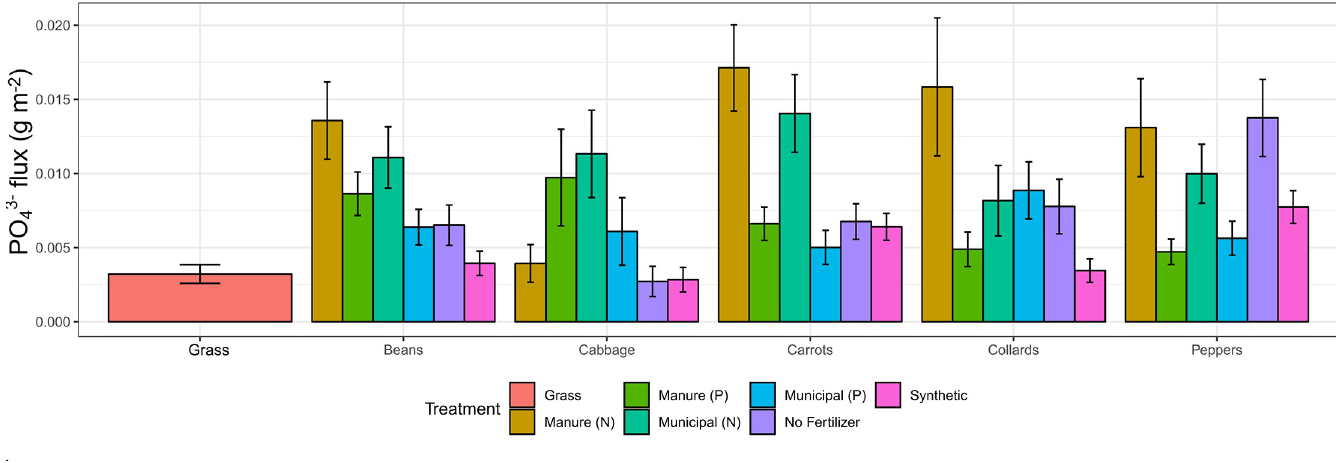
Fig 4. Mean leachate P fluxes ± 1 standard error across soil treatments per crop type. Leachate P flux from grass plots outside the garden is also included for reference.